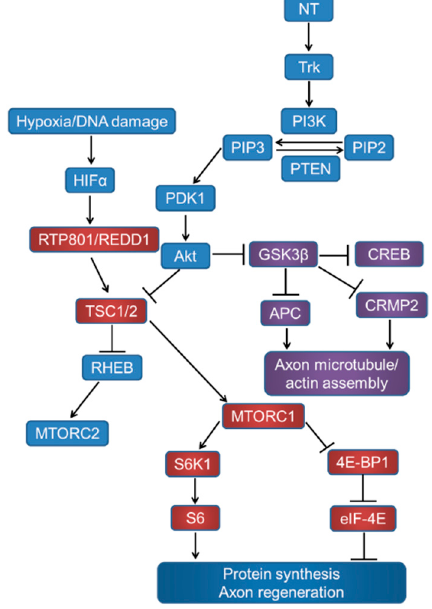
Figure 1. Signalling through the mTORC1, GSK3 β , and pathways related to proteins synthesis and axon regeneration. Neurotrophins (NT) act on tyrosine kinase (Trk) receptors and induce phosphatidylinositol kinase (PI3K) activity, which converts phosphatidylinositol (4,5) bisphosphate (PIP2) to phosphatidylinositol (3,4,5) triphosphate (PIP3). Phosphatase and tensin homolog deleted on chromosome 10 (PTEN) catalyses the reverse reaction. PIP3 activates phosphatidylinositol-dependent protein kinase 1 (PDK1), Akt phosphorylation, and inhibits tuberous sclerosis complex (TSC1 / 2). TSC1 / 2 can stimulate the Ras homolog enriched in the brain (Rheb) to upregulate mTOR activity. Akt can also inhibit GSK3 β , which in turn disinhibits CREB-mediated NT transcription, APC, and CRMP2 to promote growth cone assembly.